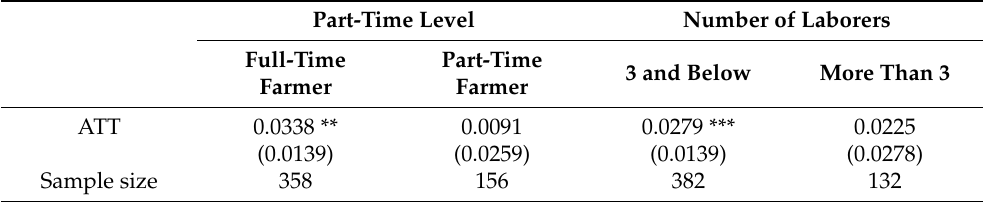
Table 10. Heterogeneity analysis based on family characteristics.